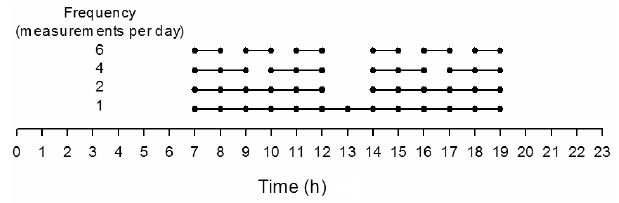
Figure 3. Windows of time for randomly selecting measurements of different sampling frequencies, for the only daytime sampling. The lines represent the windows of time and the dots represent the exact time of